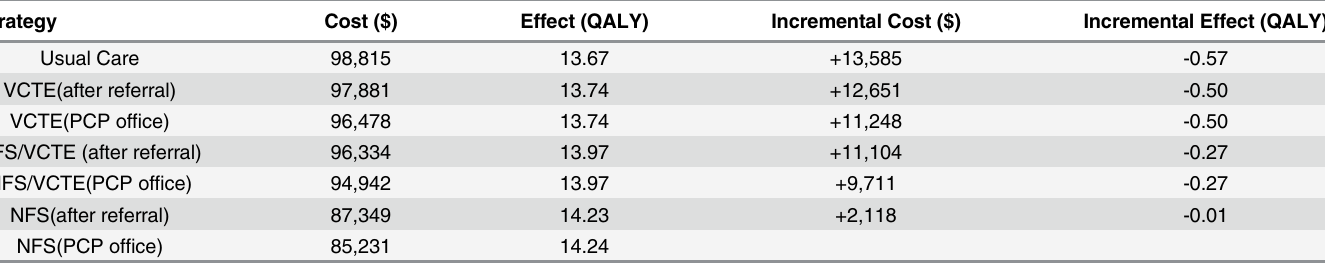
Table 2. The Cost and Effect of Non-invasive Evaluations of Nonalcoholic Fatty Liver Disease (NAFLD) Compared to Usual Care (Liver Biopsy) in the Primary Care and Referral